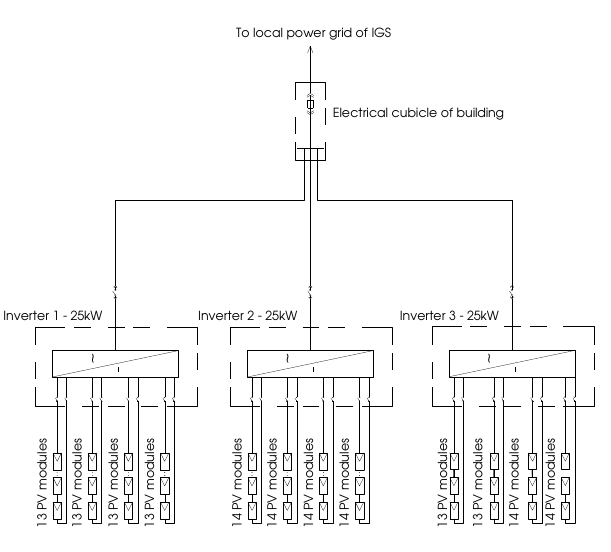
Figure 7 . Diagram of PV system connection at the